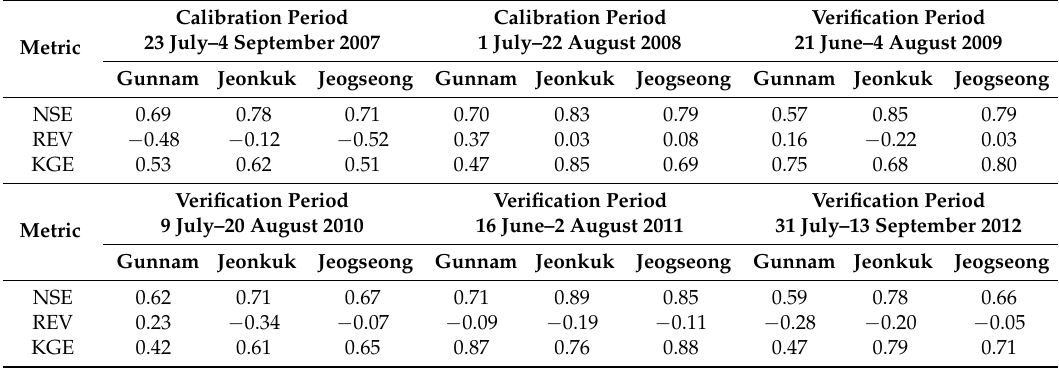
Table 1. Statistical analysis for the simulated discharge for the calibration and verification periods in the SURR